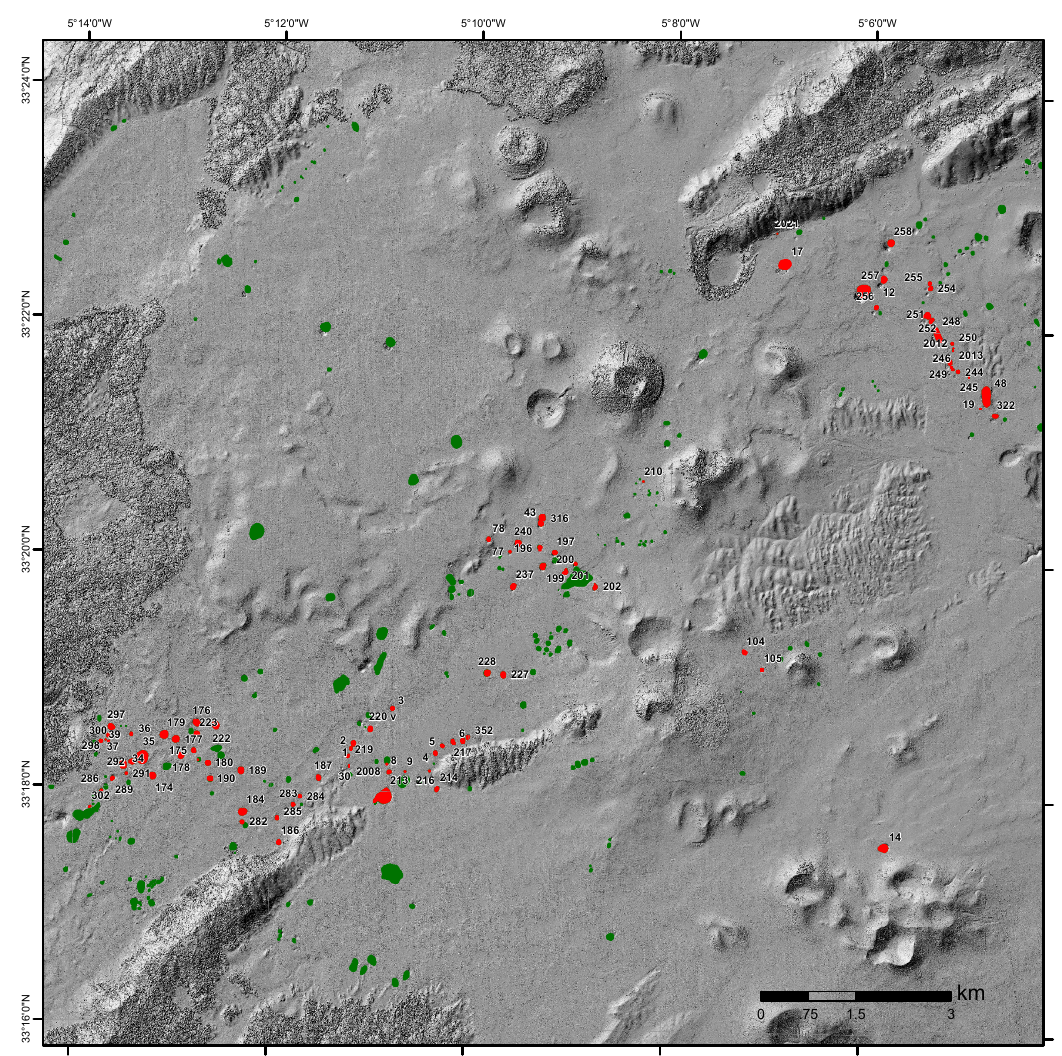
Figure 6. Shaded relief map extracted from the processing of the Pleiades-derived DEM of the study area. Sinkholes checked in the field and used to validate the DEM-derived morphometric parameters are reported in red; sinkholes identified from photointerpretation are shown in green .